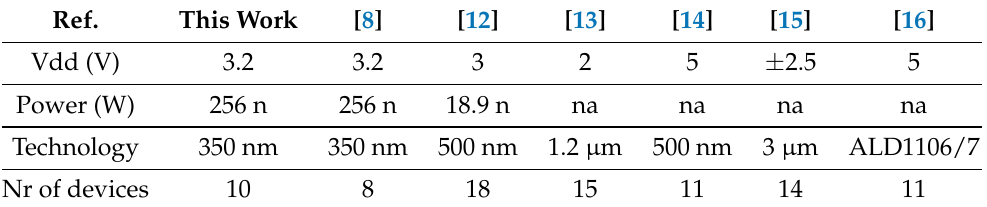
Table 1. Comparison of bump circuits. <Nr of devices> in the table is the minimum number of devices needed to realize the circuit. Results from “[8]” in the figure below are from the presented work. Ref.